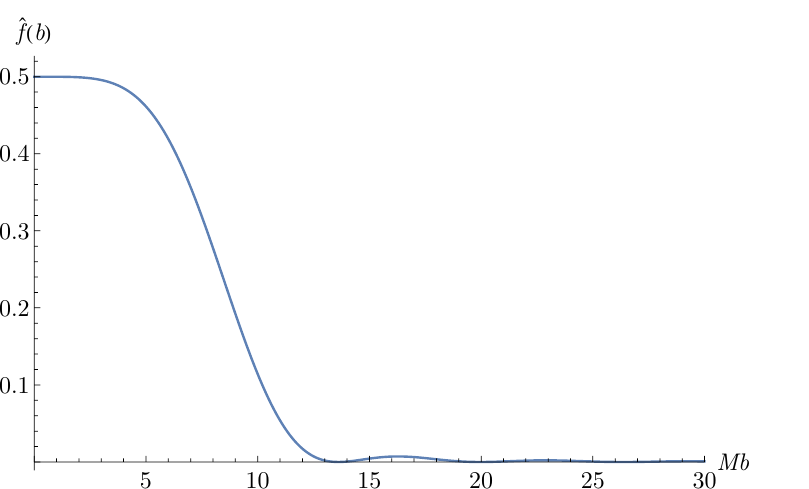
Figure 5 . The impact parameter wavefunction b f ( b ) defined by (3.1) for the extremal functional that minimizes g 2 in D = 6 . As discussed in the text, it is localized near b ∼ 1 /M . The wavefunction is normalized by b f (0) = 1 / 2 so that the contribution of g 2 in (3.16) is precisely g 2 . The fact that it has zero slope at b = 0 guarantees that the contribution of g 3